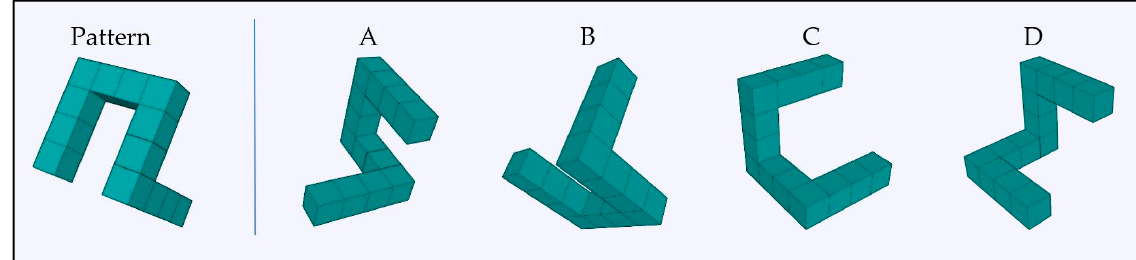
Figure 3. MRT sample question.